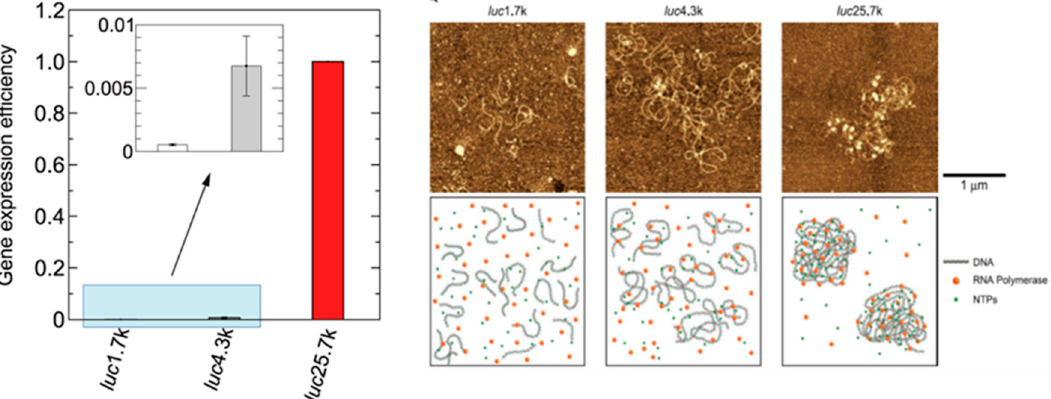
Figure 19. Left: Difference in the gene expression efficiency dependent on the size of template plasmid DNA. Right: AFM (atomic force microscopy) images of each linear reporter DNA in the reaction mixture for cell ‐ free gene expression, together with the schematic representations on the bottom. (Note: This figure is a modified figure that was originally published under CC ‐ BY license in [175]).